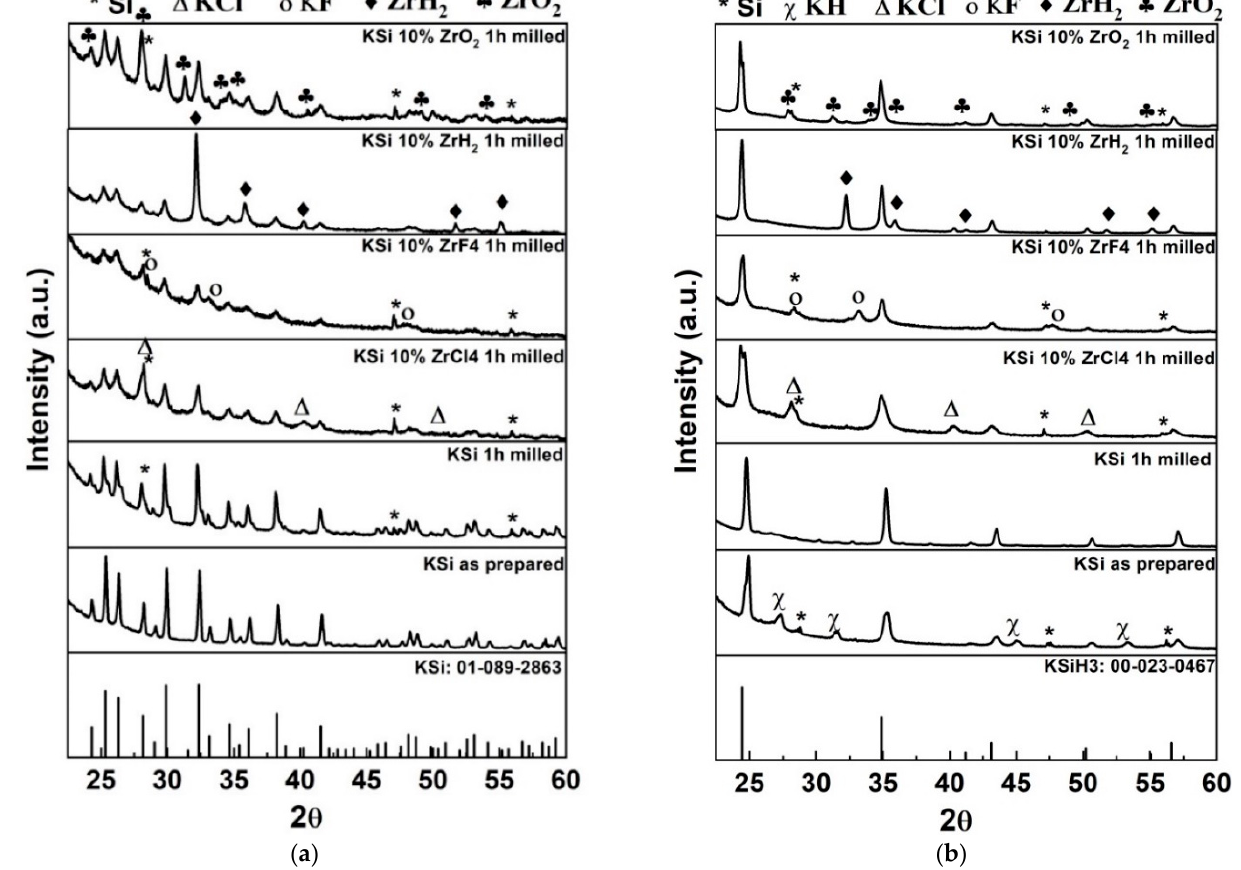
Figure 1. XRD pattern of ( a ) as prepared ( b ) hydrogenated KSi samples with and without catalysts. The phases are shown as Si (*), KCl ( Δ ), KF (o), ZrH 2 ( ◆ ), ZrO 2 ( ♣ ), and KH ( χ ).